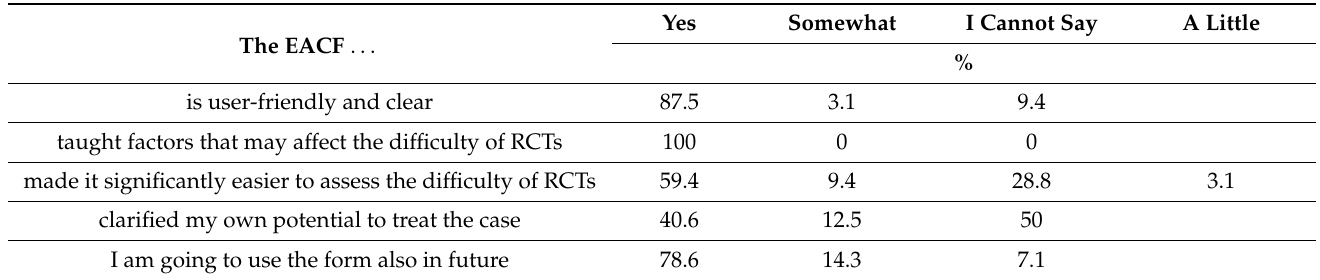
Table 3. Distribution of fifth-year dental students ( n = 32) according to their responses on the claims about Endodontic Case Difficulty Assessment Form (ECAF) for root canal treatments (RCT) as well as their estimation on its use in future. The EACF . .